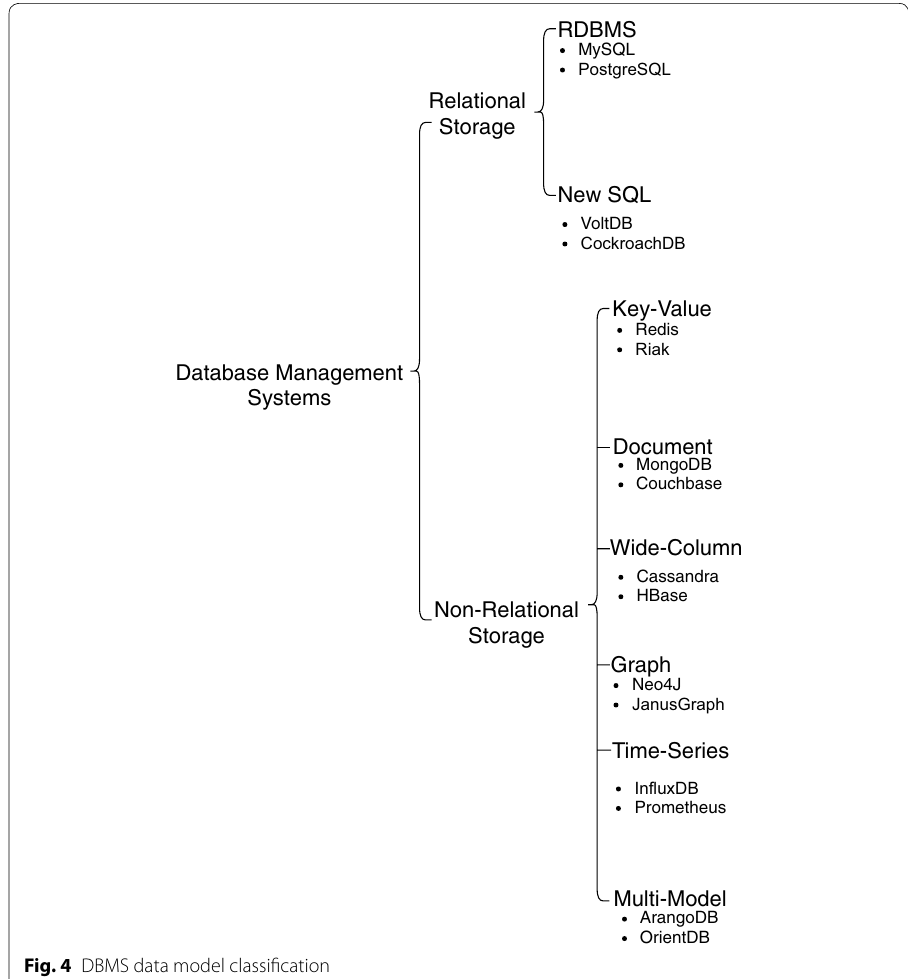
Fig. 4 DBMS data model